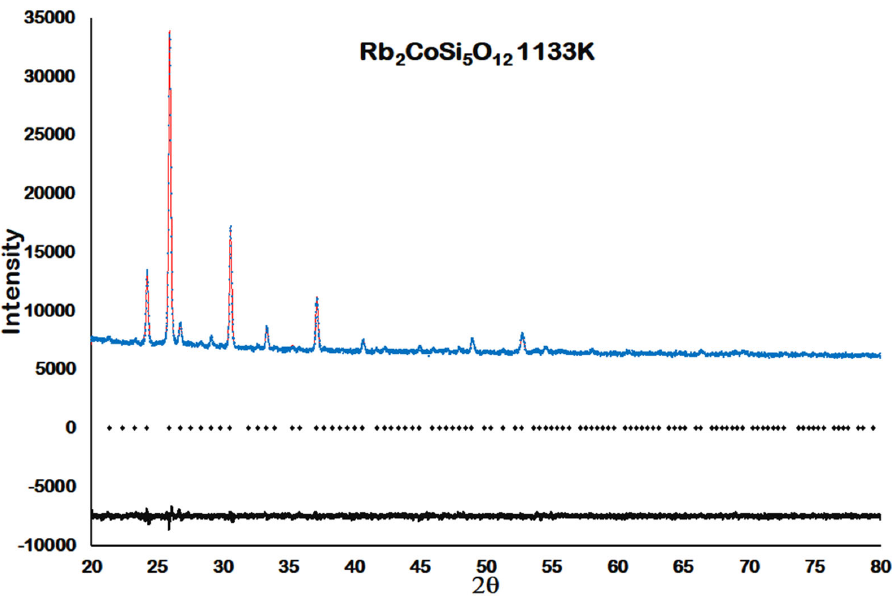
Figure 10. 1133 K (MgO calibrated temperature) Rietveld difference plot for Rb 2 CoSi 5 O l2 . Blue dots show observed data, red line shows calculated data, black line shows difference plot and black diamonds show positions of Bragg reflections. Table 5. Refined atomic coordinates for 1133 K Rb 2 CoSi 5 O l2